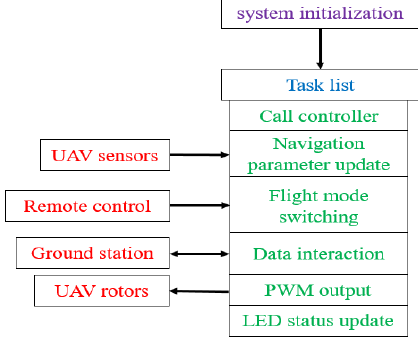
Figure 19. UAV software